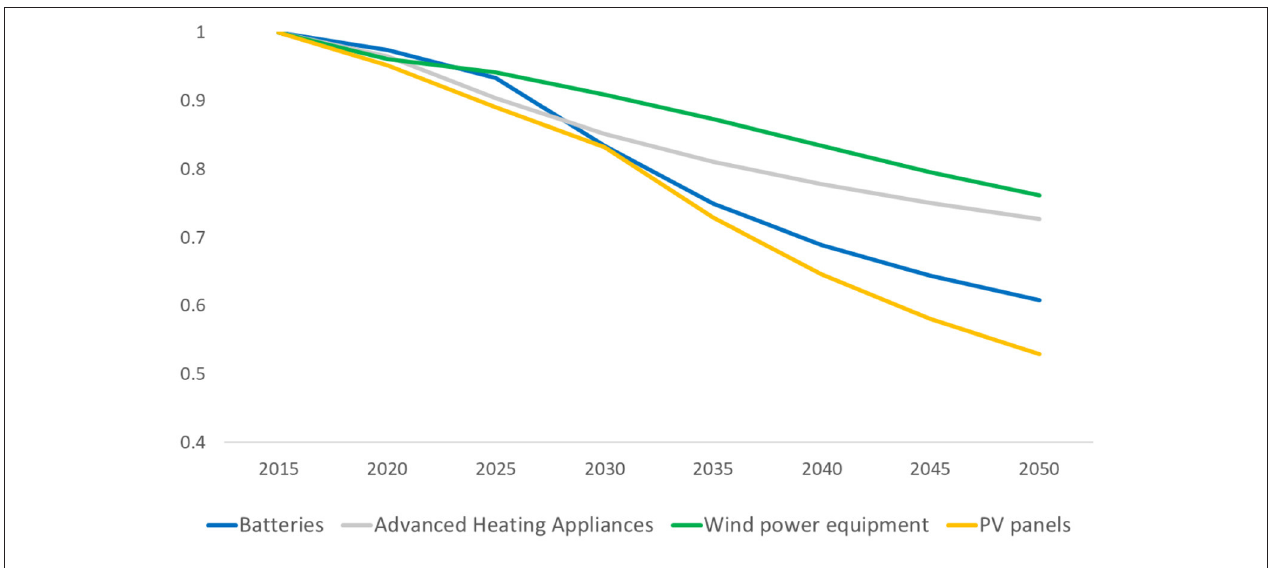
FIGURE 11 | Low-carbon technology costs in the 2DEG scenario (indexed to 2015).